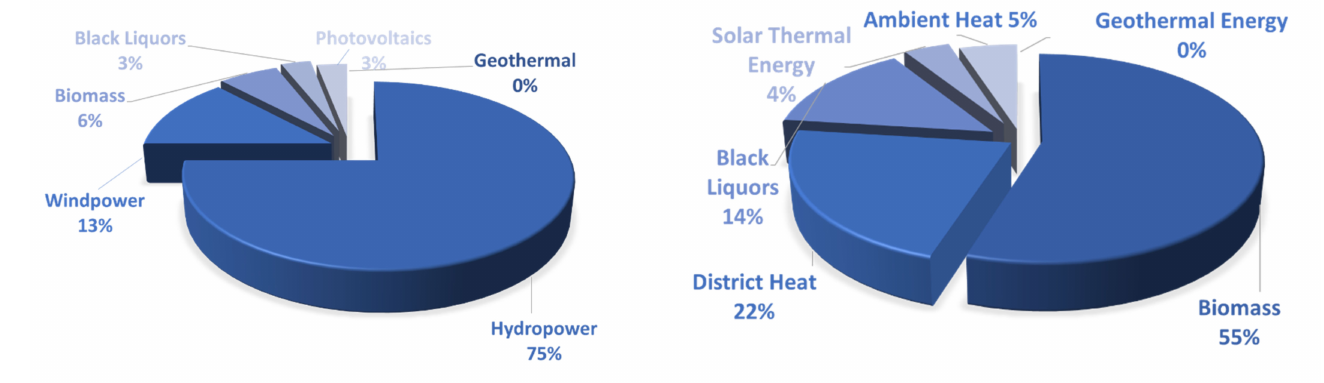
Figure 6. Contributions to Austrian heat (right) and electricity generation by REN in 2017 (adapted from [61] with permission from Biermayr